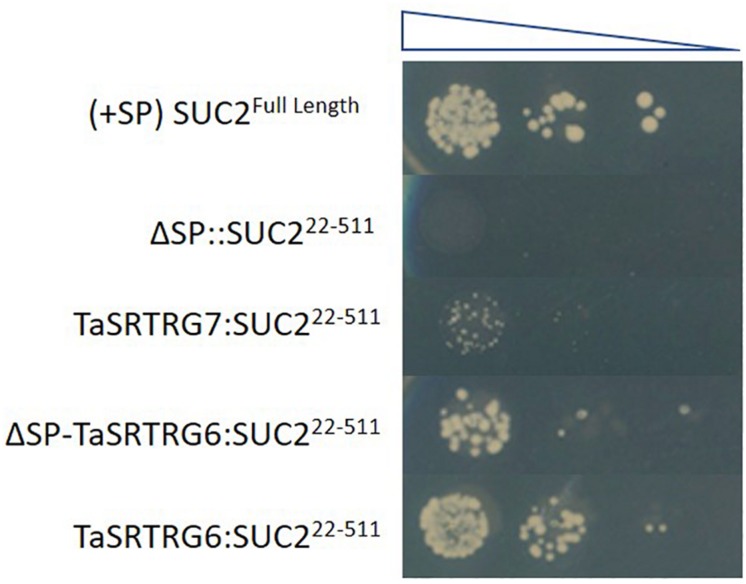
Testing of wheat taxonomically restricted genes (TRGs) secretion using a yeast expression system. The expression of the TaSRTRG6 with a positive secretion signal results in the secretion of the SUC2 protein allowing the growth of yeast transformants on the sucrose-containing media. The TaSRTRG7 transformants without a secretion signal cannot grow on media. (+SP) SUC2Full Length denotes the yeast strain transformed with the full length SUC2 (with signal peptide) gene and served as a positive control while ΔSP:SUC222–511 denotes the yeast strain transformed with the full length SUC2 (without signal peptide) and served as a negative control. TaSRTRG7:SUC222–511 represents the yeast strain transformed with the full length SUC2 (with signal peptide) gene and TaSRTRG7. TaSRTRG6:SUC222–511 represents yeast strain transformed with the full length SUC2 (with signal peptide) gene and TaSRTRG6 while ΔSP-TaSRTRG6:SUC222–511. This experiment included 9 biological replicates (3 × 3 trials) per construct per dilution.